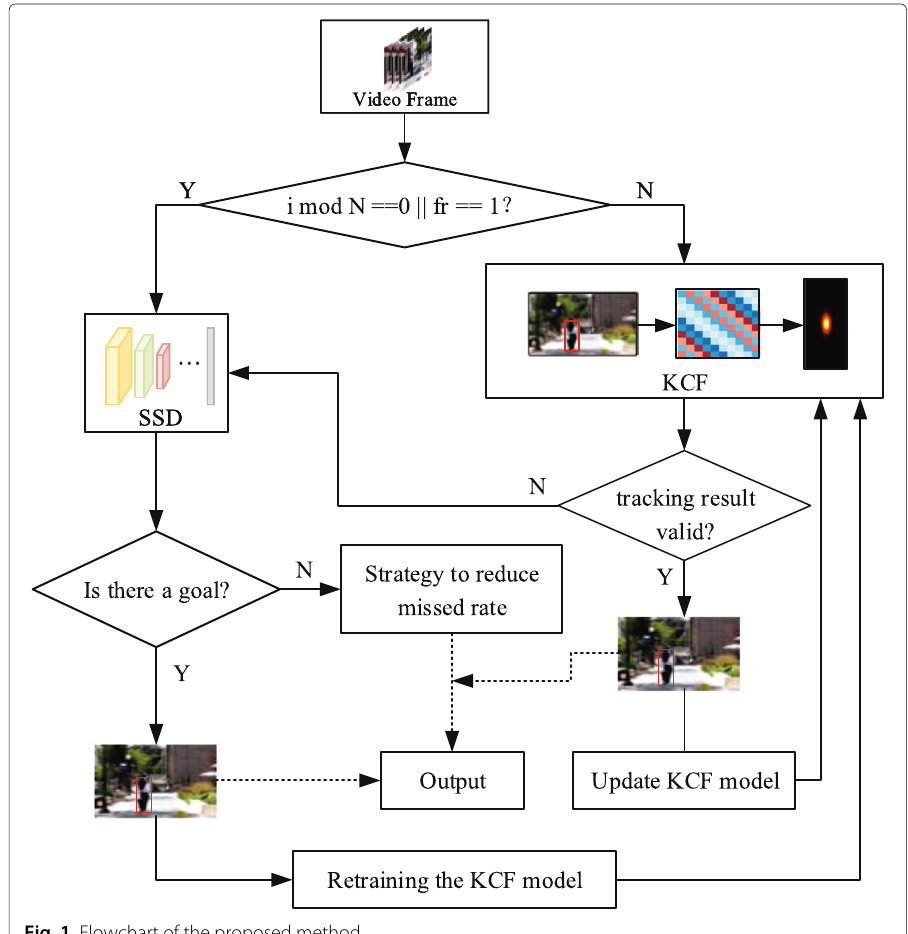
Fig. 1 Flowchart of the proposed